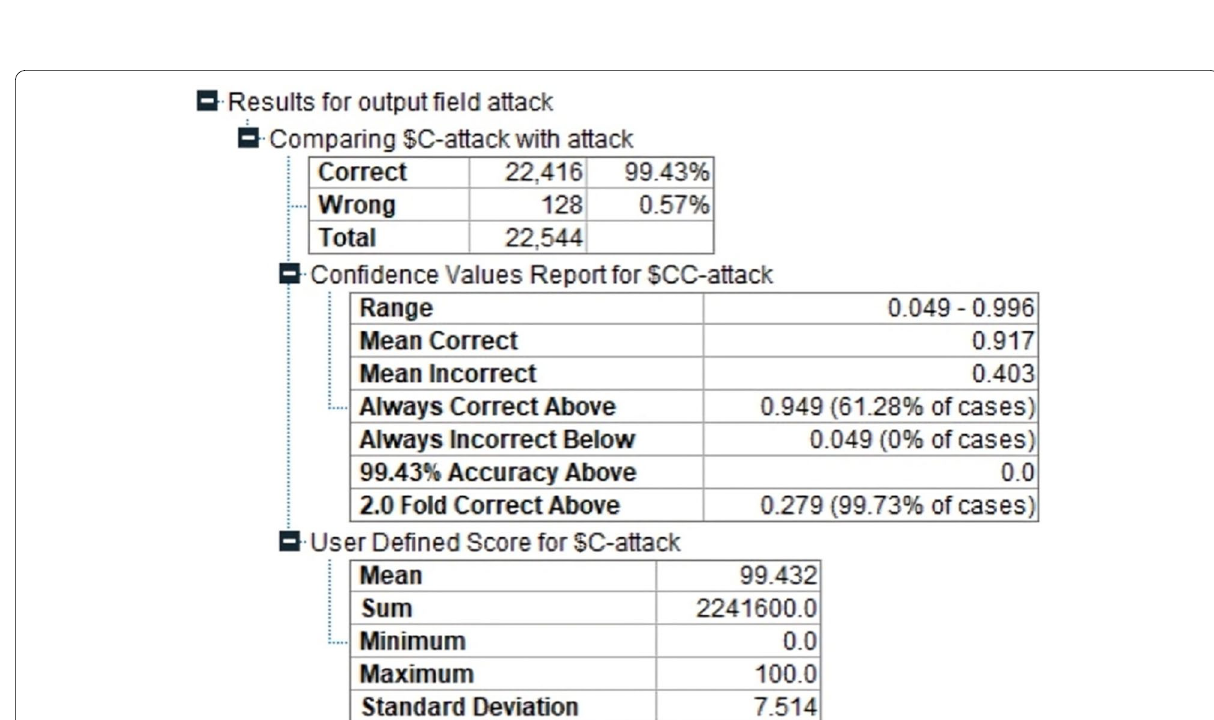
Fig. 17 accuracy level in Proposed AdaCybrog